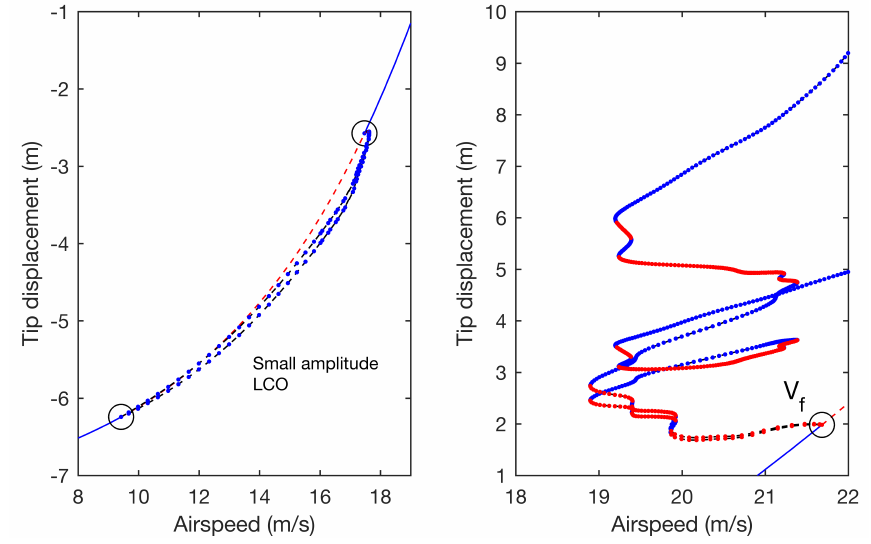
Figure 11. One-parameter continuation of equilibria and LCOs for varying airspeed for EI out =